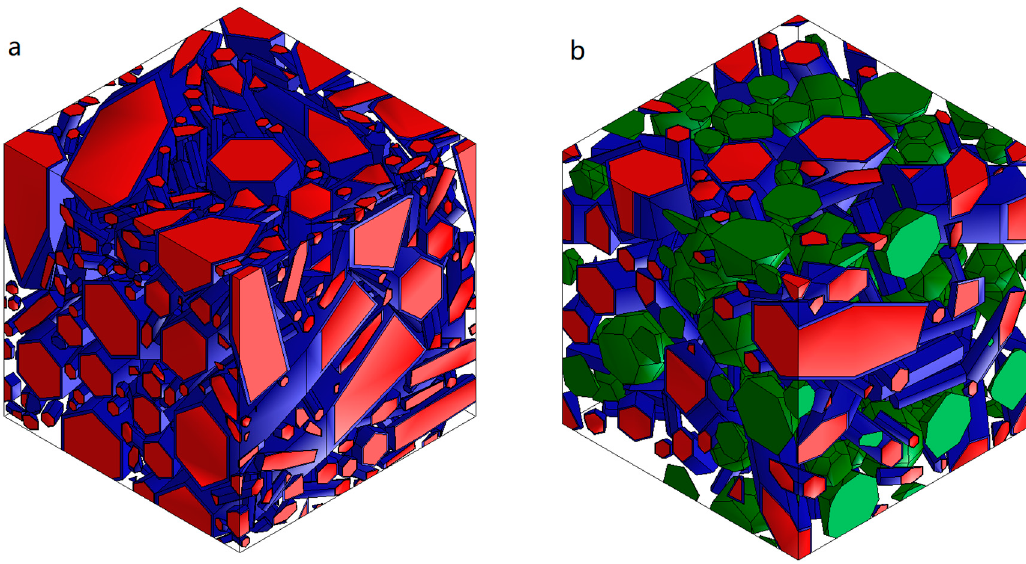
Figure 5. 3D microstructure of ( a ) polycrystalline silicon nitride and ( b ) silicon nitride-based composite materials with 20 vol % of secondary phase; red colour- silicon nitride grains, green colour- secondary phase grains, navy blue color- amorphous oxide phase.